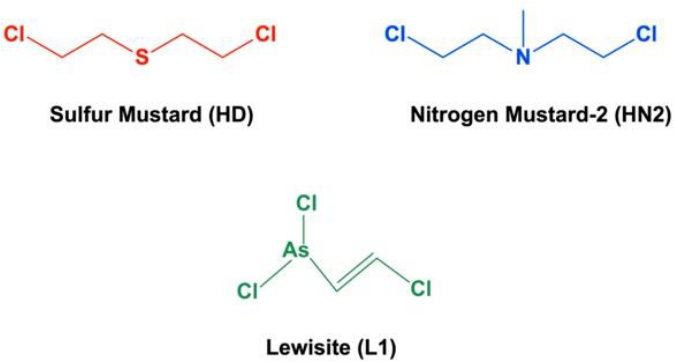
Figure 1. Chemical structure of the most representative blister agents.